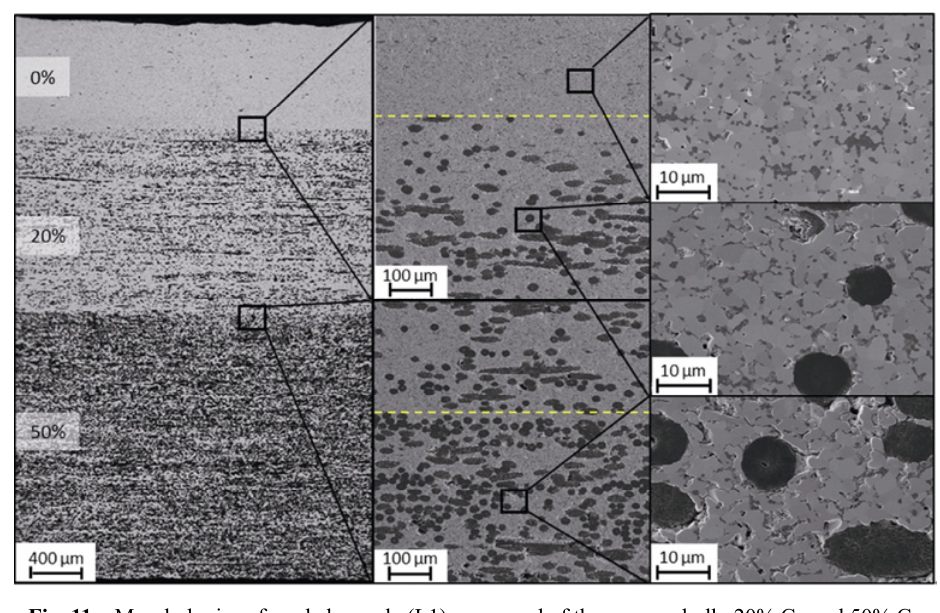
Fig. 11 Morphologies of graded sample (L1) composed of three areas: bulk, 20% C f , and 50% C f .